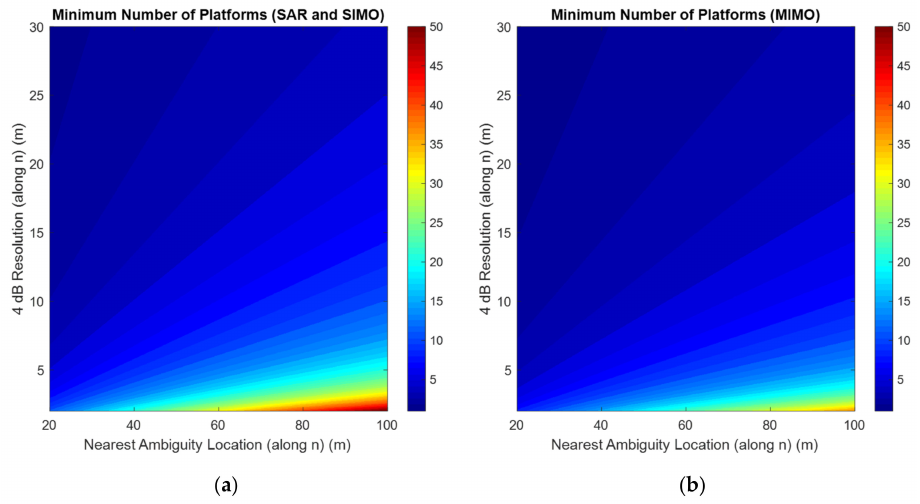
Figure 14. The minimum number of platforms required for a specific tomographic resolution (along n ) and nearest ambiguity location (along n ) for ( a ) SAR, SIMO, and ( b ) MIMO modes. The maximum number of platforms required is 50 for SAR and SIMO, and 35 for